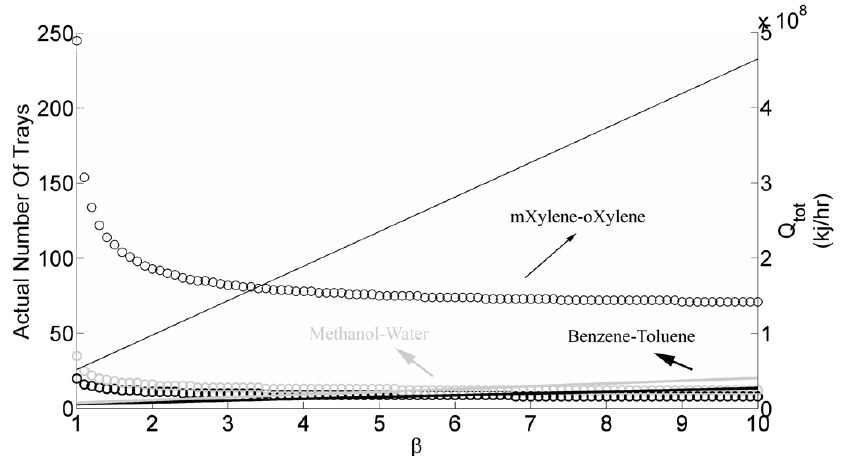
Figure 6. Effect of β on the actual number of trays and total required duty for conditions of Table 2. The operating cost curve must therefore pass through a minimum at the optimum reflux ratio.